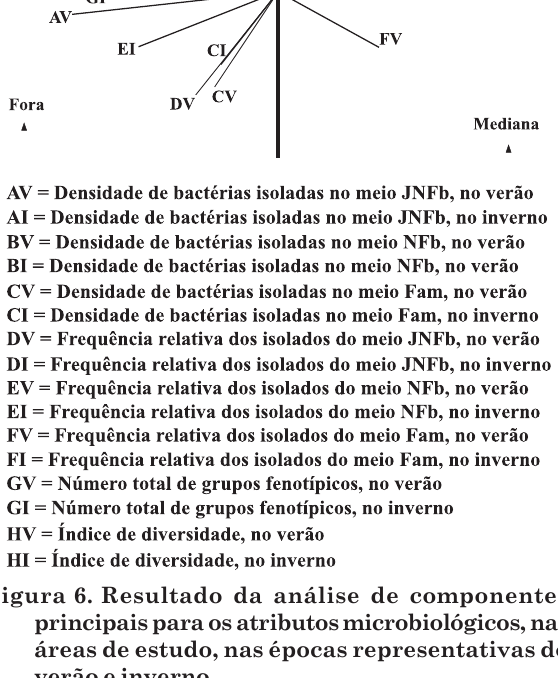
Figura 6. Resultado da análise de componentes principais para os atributos microbiológicos, nas áreas de estudo, nas épocas representativas do verão e